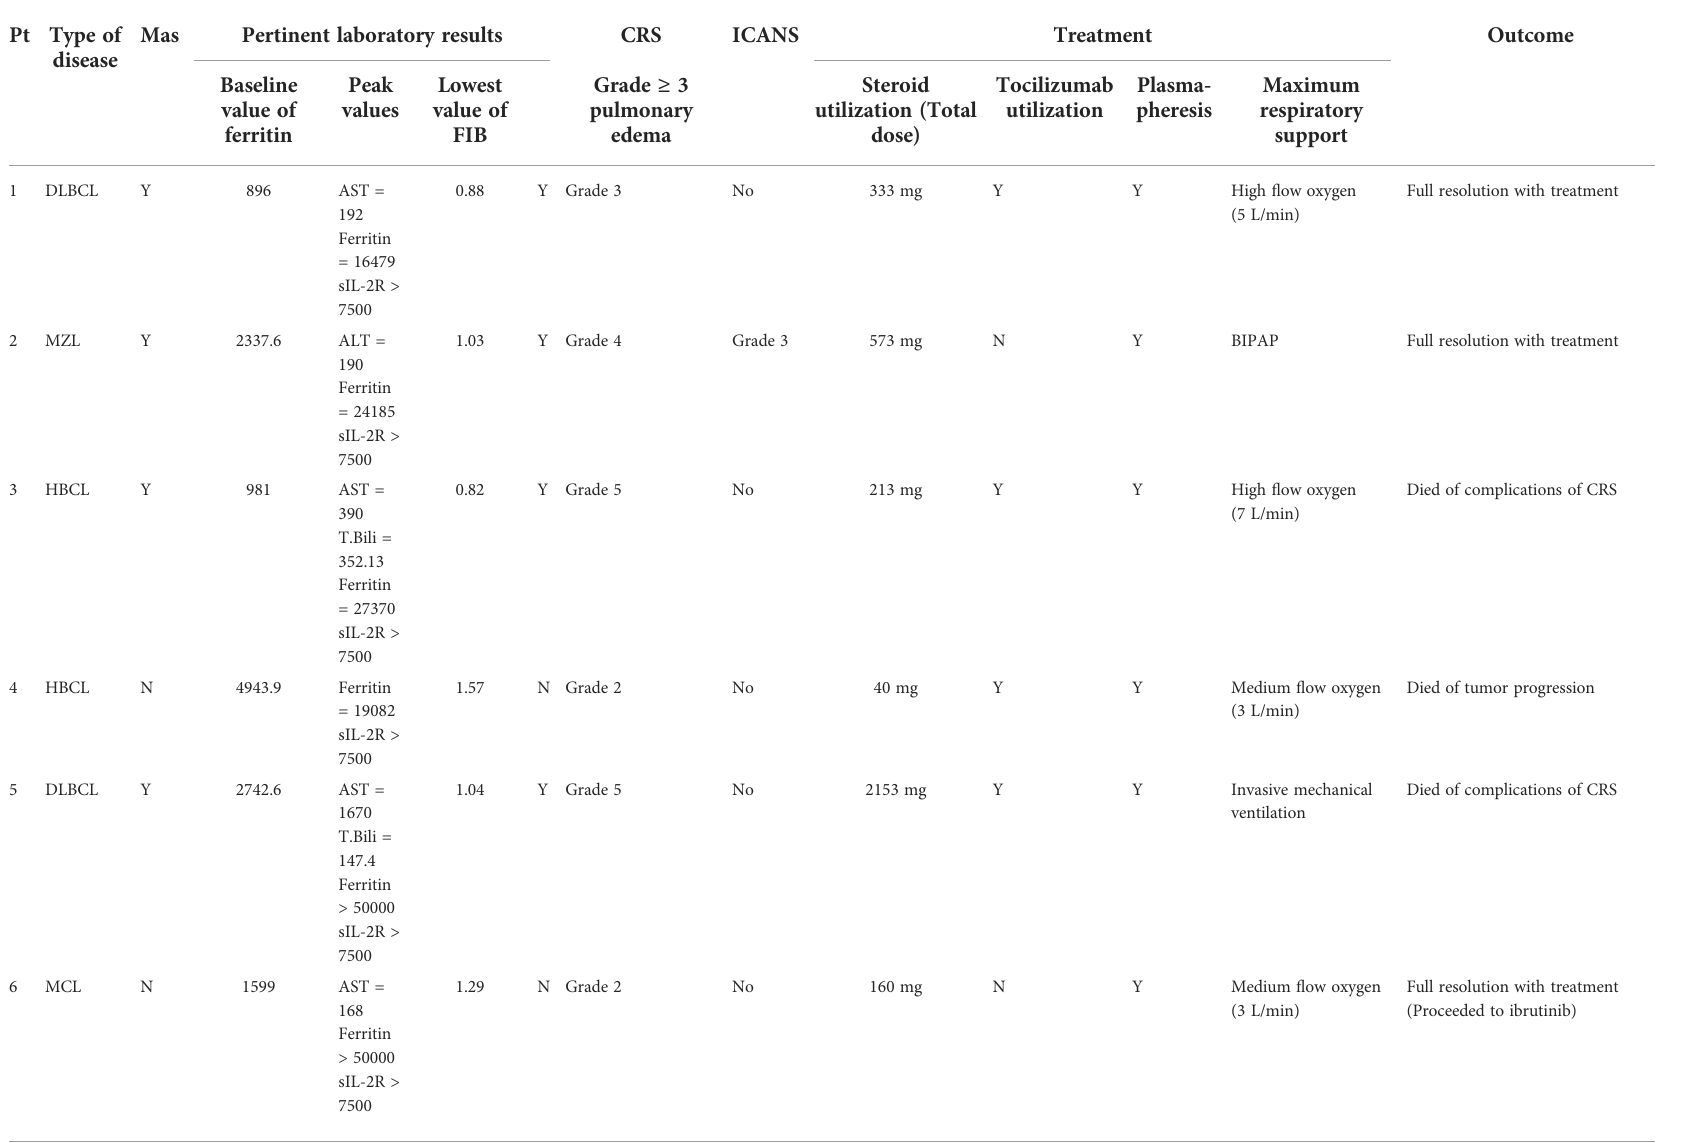
TABLE 3 Manifestations of hyperferritinaemia, treatment approach and